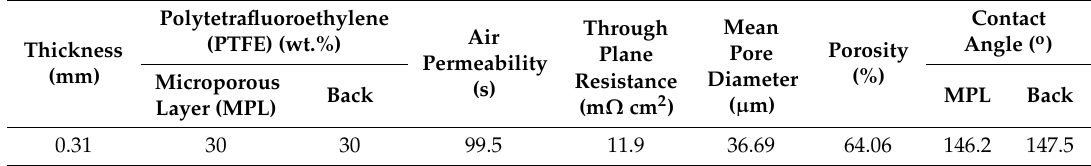
Table 1. Physical properties of gas di ff usion layer